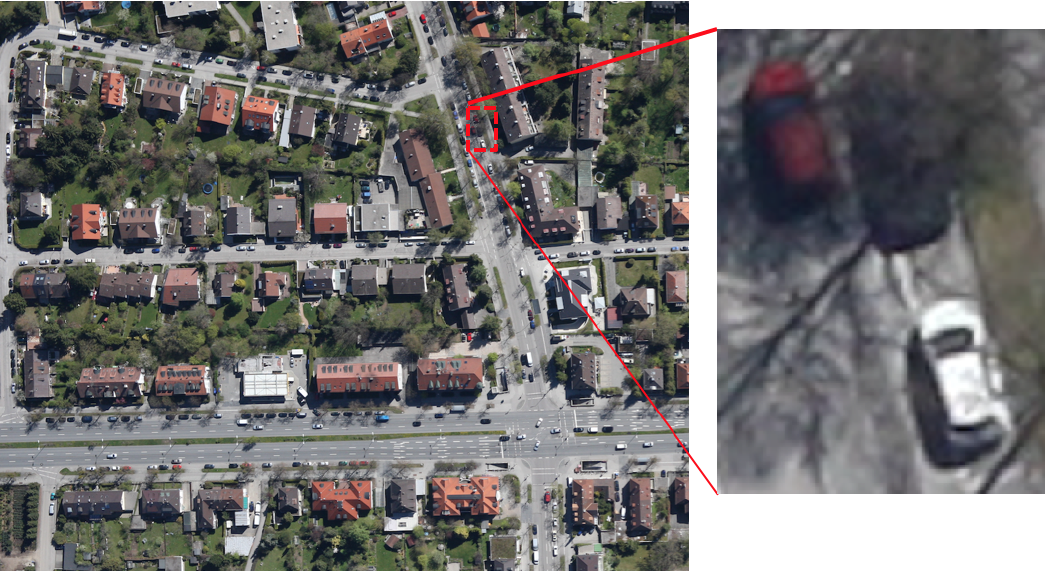
Figure 4. Example of an image crop from the MUNICH data set